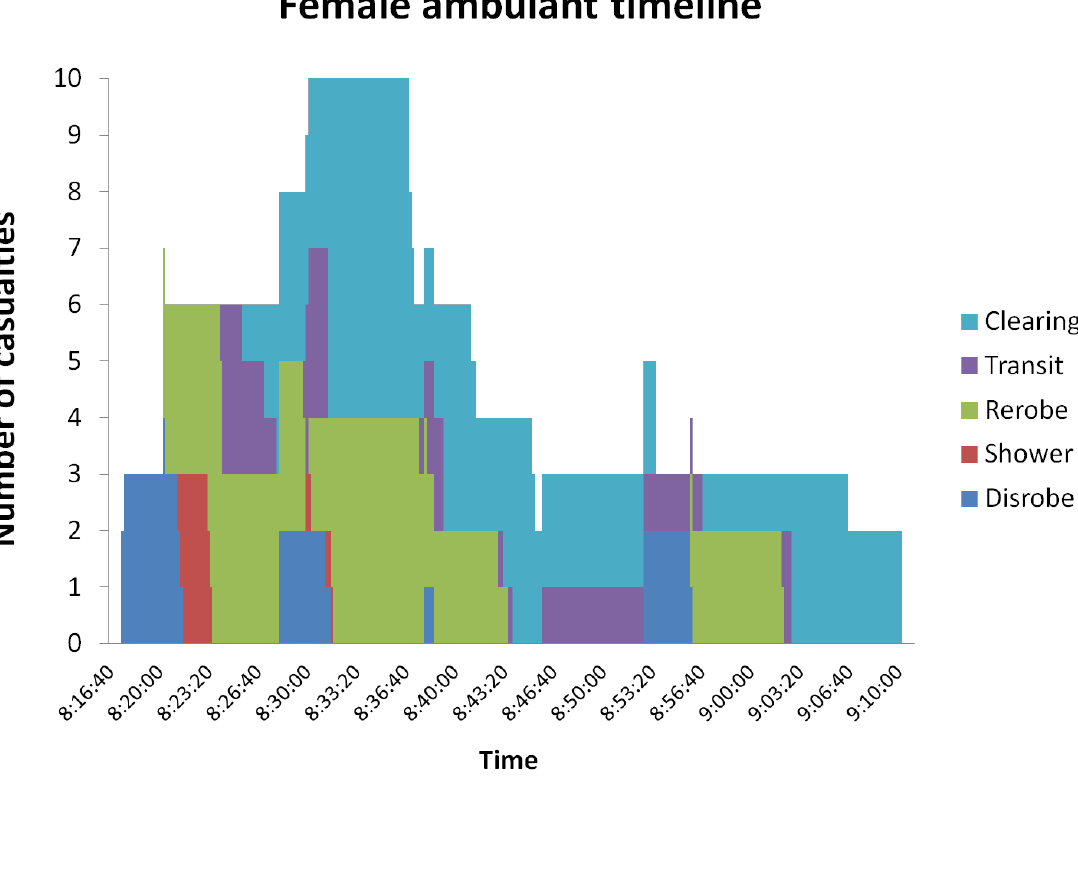
Figure A4. 13 female ambulant casualties passed through the disrobe , shower and re-robe sections of the MD1 before a transit to the casualty clearing station. The times on the x-axis correspond to the approximate timing of the start of the flow control system‘s green light; the graph represents 10 second time slices. Only 1 group of 3 casualties spent more than 30 seconds in the shower but this group didn‘t stay in for the full 3 minute duration. For a period of approximately 30 seconds the re-robe section contained 6 casualties, 1 greater than the intended capacity of 5. For a number of casualties a significant amount of time was taken in transit, a distance of approximately 30